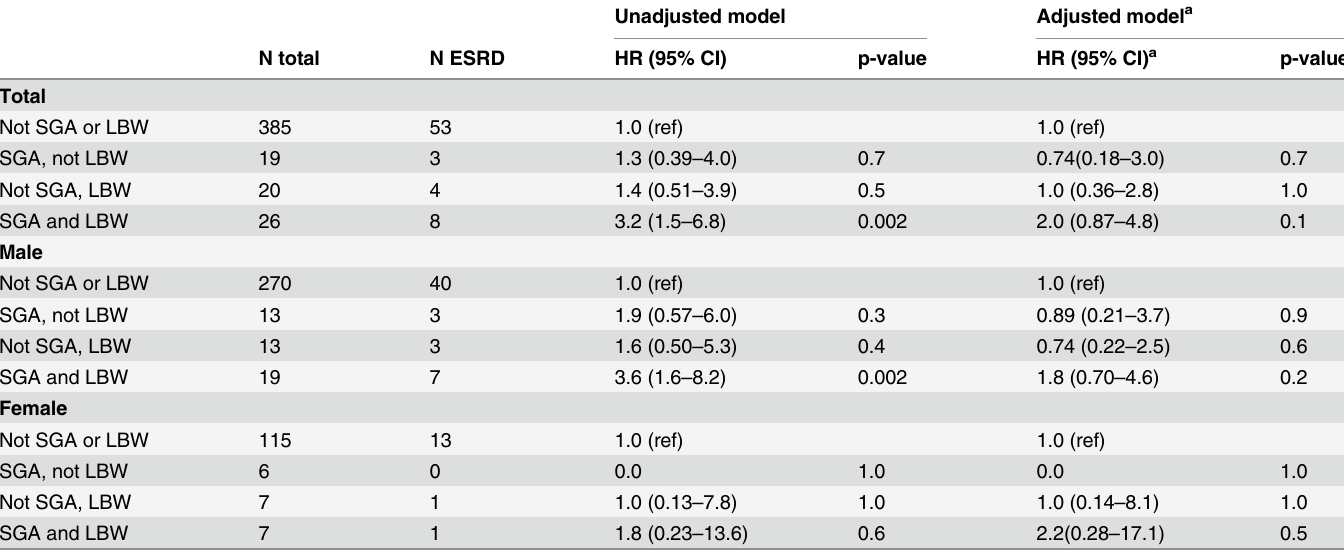
Table 4. Risk of ESRD among IgAN patients stratified by LBW, SGA or the combination of these,